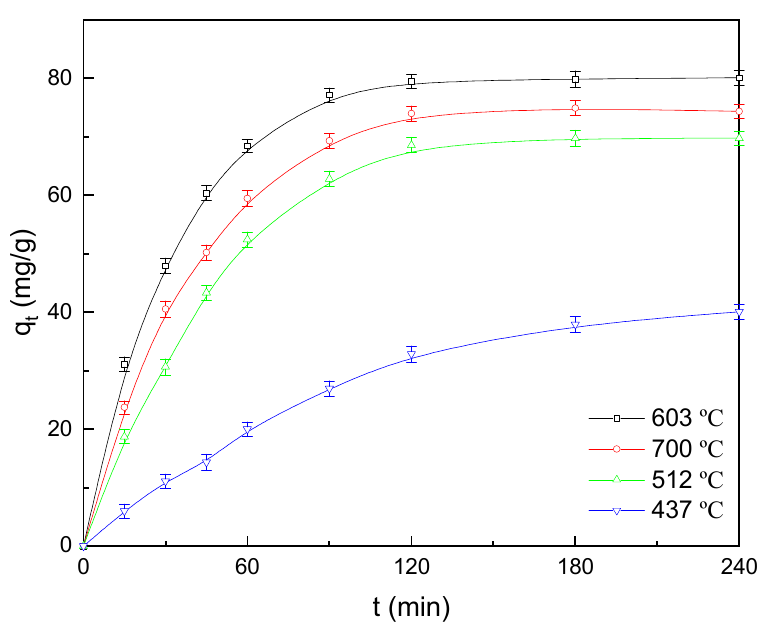
Figure 3. The e ff ect of pyrolysis temperature on adsorption of Figure 3. The effect of pyrolysis temperature on adsorption of char.